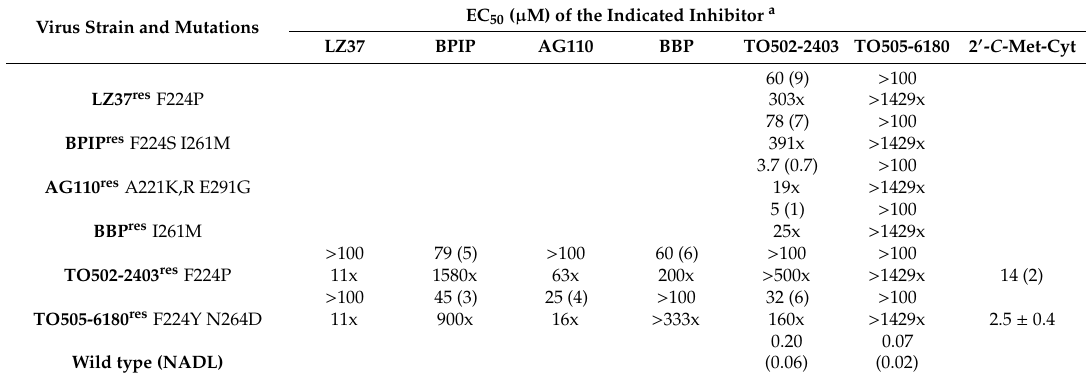
Table 1. Susceptibility of the bovine viral diarrhea virus (BVDV) wild-type (NADL) and drug-resistant BVDV strains to di ff erent